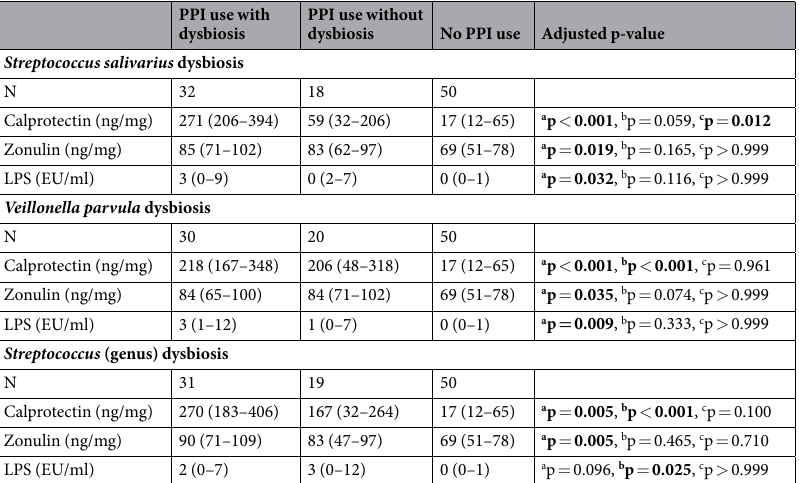
Table 3. Faecal calprotectin, faecal zonulin and serum LPS for patients with PPI-associated dysbiosis. Data is given as Median and 95% confidence interval. PPI: proton pump inhibitor; a denotes differences between patients with PPI use with dysbiosis and patients without PPI use; b denotes differences between patients with PPI use without dysbiosis and patients without PPI use; c denotes differences between patients with PPI use with and without